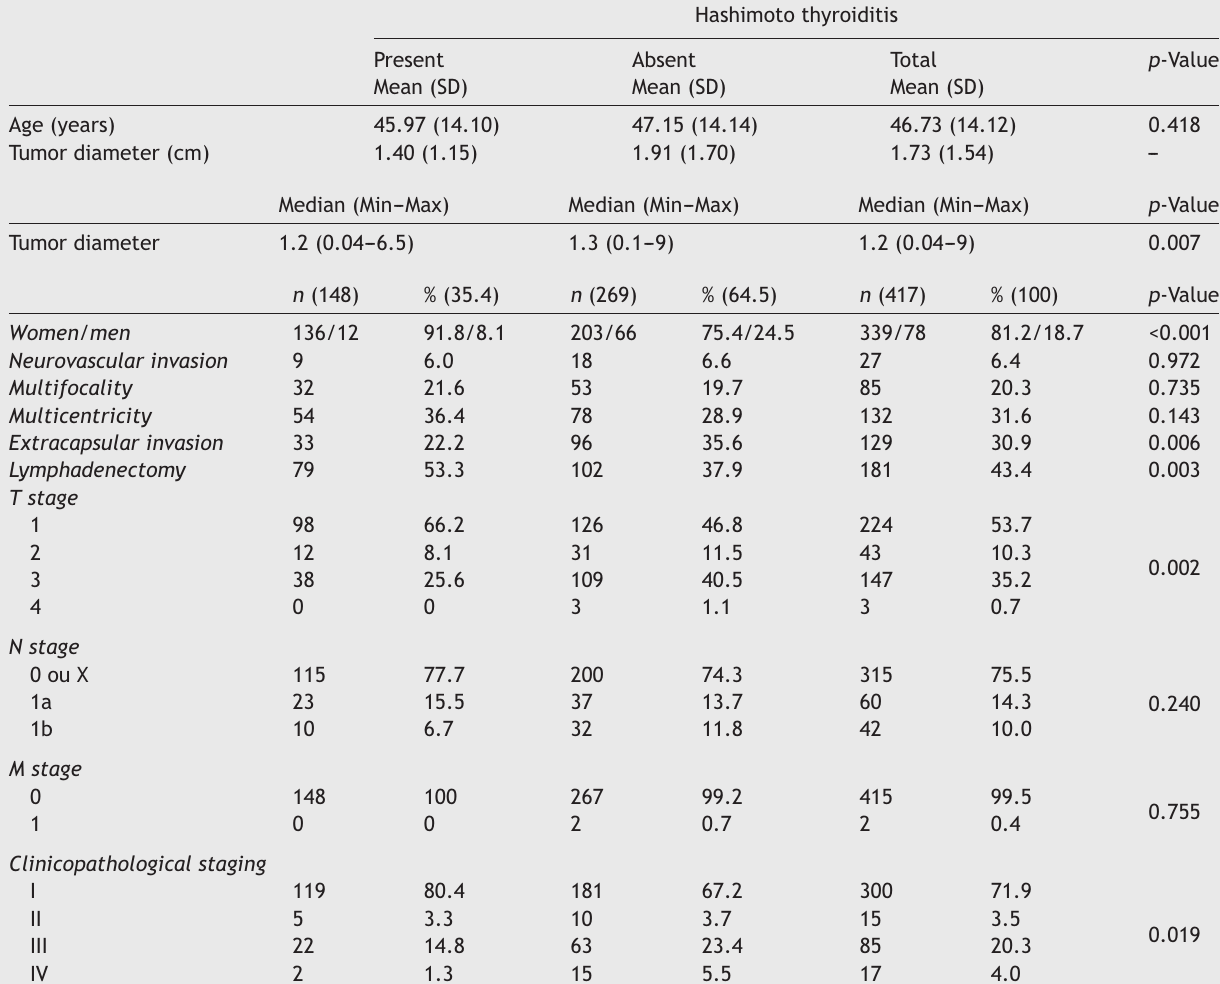
Table 1 Analysis of clinical and pathological characteristics according to the presence or absence of Hashimoto thyroiditis among cases of papillary thyroid